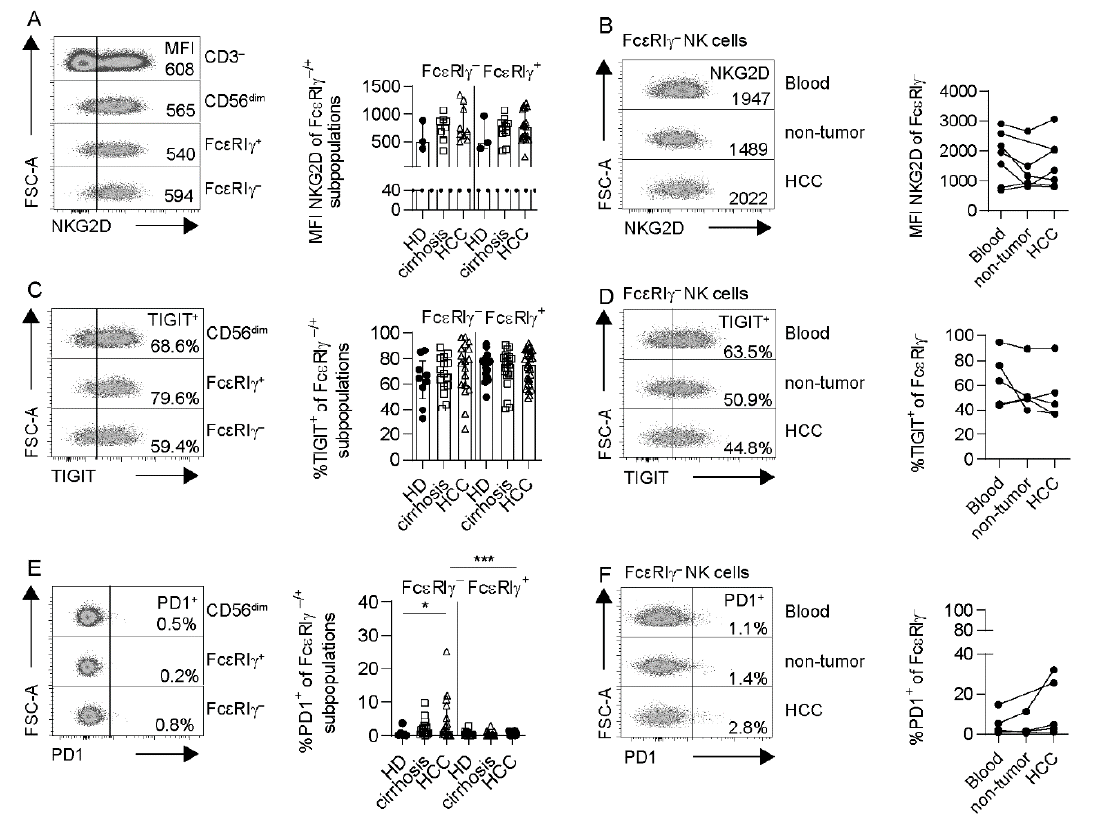
Figure 4. Checkpoint receptor expression of NK cells in HCC patients. MFI of NKG2D ( A , B ), expression of TIGIT ( C , D ) and PD1 after deduction of FMO ( E , F ) of Fc ε RI γ -subpopulations in HCC patients (Fc ε RI γ - n = 9 in ( A ), n = 18 in ( C ), n = 16 in ( E ), Fc ε RI γ + n = 17 in ( A ), n = 30 in ( C ), n = 25 in ( E )), HD (Fc ε RI γ - n = 3 in ( A ), n = 9 in ( C ), n = 6 in ( E ), Fc ε RI γ + n = 3 in ( A ), n = 18 in ( C ), n = 13 in ( E )) and patients with liver cirrhosis (Fc ε RI γ - n = 8 in ( A ), n = 15 in ( C ), n = 14 in ( E ), Fc ε RI γ + n = 11 in ( A ), n = 22 in ( C ), n = 18 in ( E )) (left) and in HCC patients’ blood ( n = 7 in ( B ), n = 5 in ( D , F )) compared to non-tumor ( n = 6 in ( B ), n = 4 in ( D, F )) and HCC lesion ( n equal to blood) (right). Each dot represents an HCMV + individual with more than 10% adaptive Fc ε RI γ - CD56 dim NK cells, and the line connects the samples from one patient. Bars indicate median with IQR. Statistical significance was tested by using mixed-effect analysis ( A , C , E ) and the Kruskal–Wallis test ( B , D , F ). HCC: patients with hepatocellular carcinoma, HD: healthy donors, cirrhosis: patients with liver cirrhosis. *: p < 0.05; ***: p < 0.001.